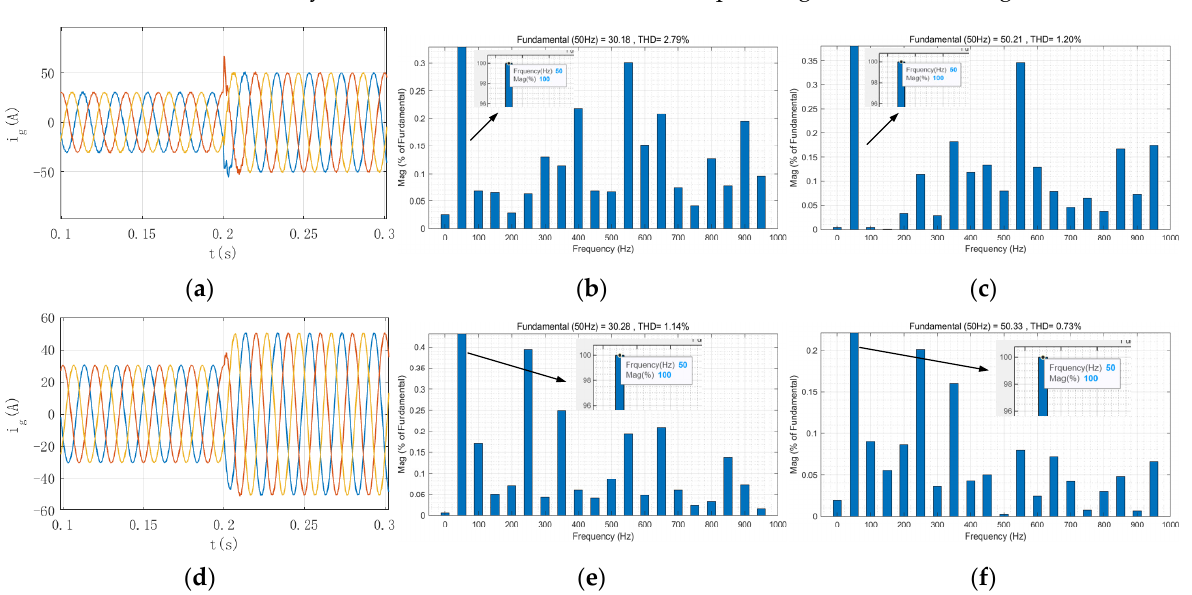
10 of 14 Table 1. System parameters. Parameter